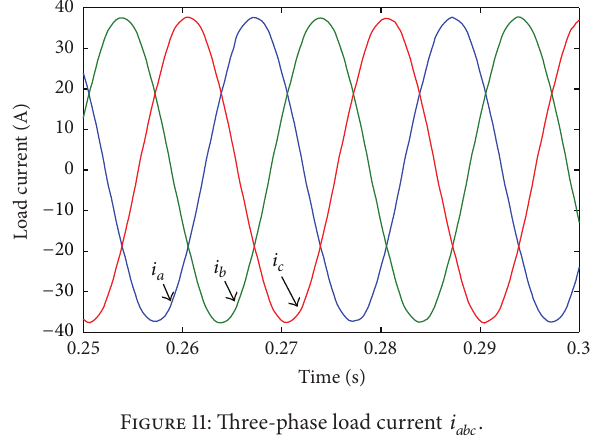
Figure 11: Three-phase load current 𝑖 𝑎𝑏𝑐 .